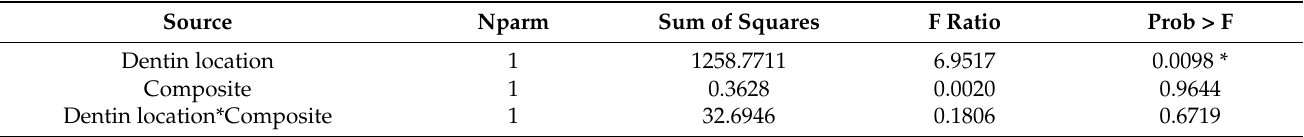
Table 2. Results of two-way ANOVA analyzing the effect of the two factors and their interaction. Star in superscript indicates a significant effect ( p <